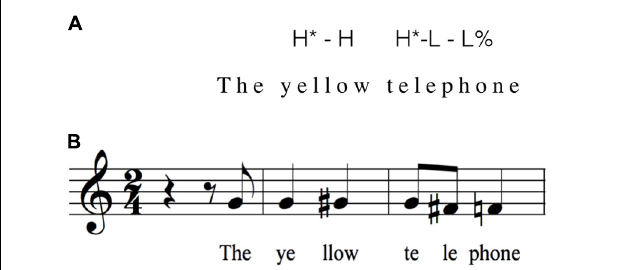
FIGURE 10 | Comparing ToBI transcription and musical transcription. The figure presents a comparison between a ToBI transcription (A) and a musical transcription (B) of “The yellow telephone.” (B) Is a reproduction of Figure 1C